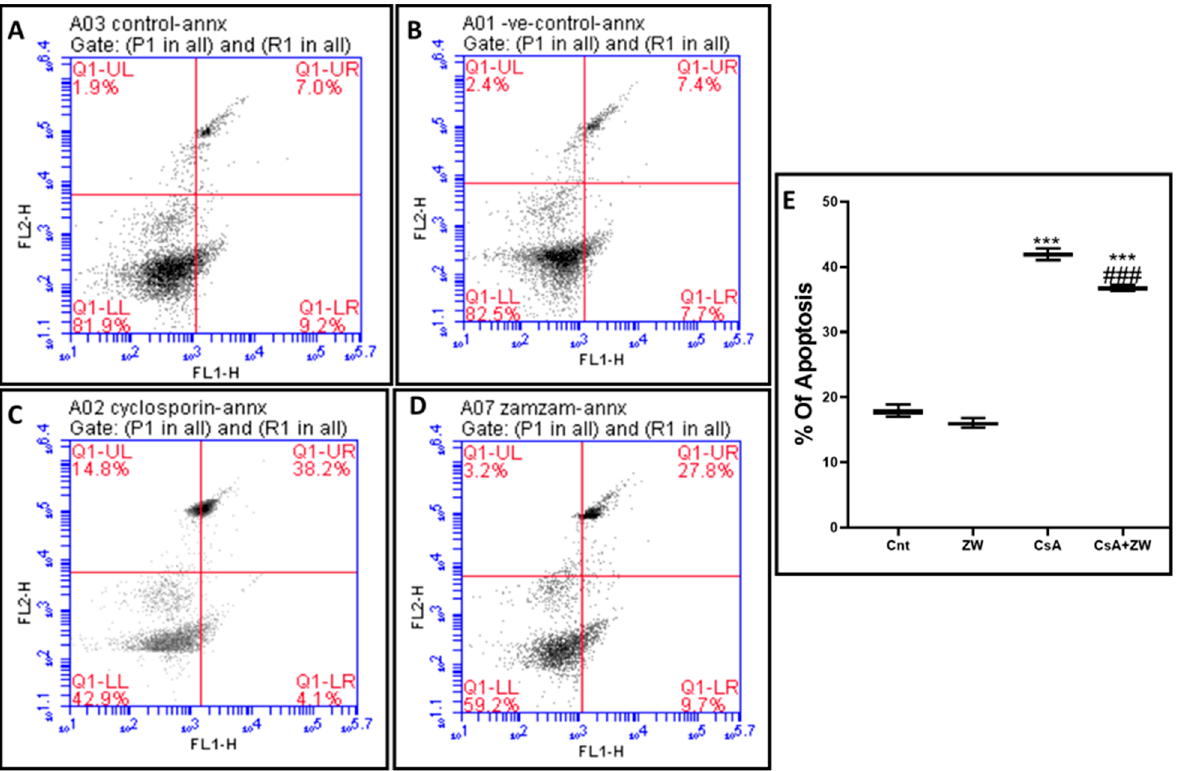
Figure 7. Flow cytometry analysis of renal tubular cells stained with the apoptotic marker Annexin V as an indi ff erent experimental group. ( A ) Control group, ( B ) ZW group, ( C ) CsA group , and ( D ) CsA + ZW group. ( E ) Histogram of apoptotic cells. *** p < 0.001 vs. control ; ### p < 0.001 vs.